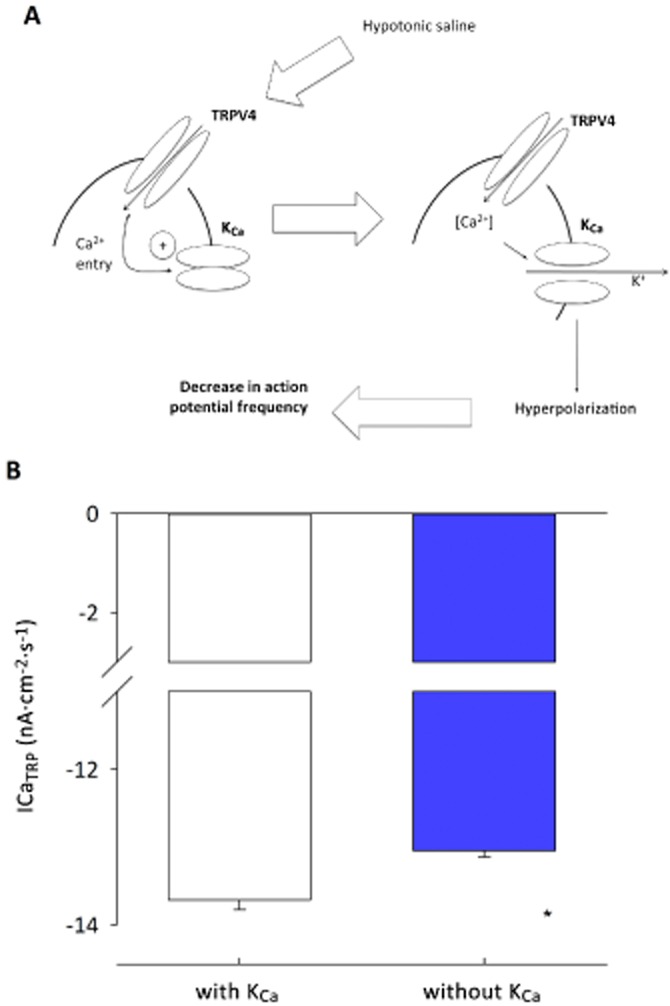
Analysis of positive feedback between TRPV4 and KCa channels in PVN neurones. (A) The simple scheme proposed by Nilius and Droogmans (2001) whereby influx of Ca2+ increases KCa channel activity which hyperpolarizes the cell and increases the inward flux of Ca2+, by increasing the driving force (G [Vm – ECa]) for Ca2+ entry. (Vm = membrane potential, ECa is the equilibrium potential for Ca2+ ions and G is the conductance of the Ca2+ entry pathway). (B) Running a number of simulations reveals a significant decrease (n = 7; *P < 0.001) in mean Ca2+ influx in the presence of KCa channels, as predicted. See Figure 6 for experimental verification.